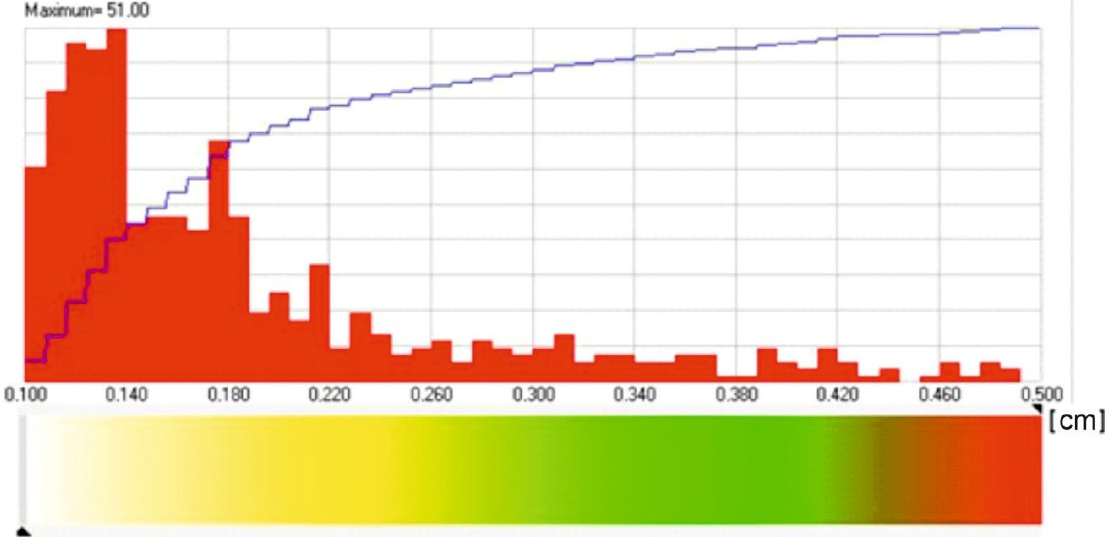
Figure 11. Results of the processing and interpretation of electric imager log for macrofracture determination in the se- lected depth section of the G-10 well: GRTC—gamma ray log without uranium component; GRTO—total gamma ray; MD—measured depth, changed; FR_—fractures; FPI—fracture porosity index.